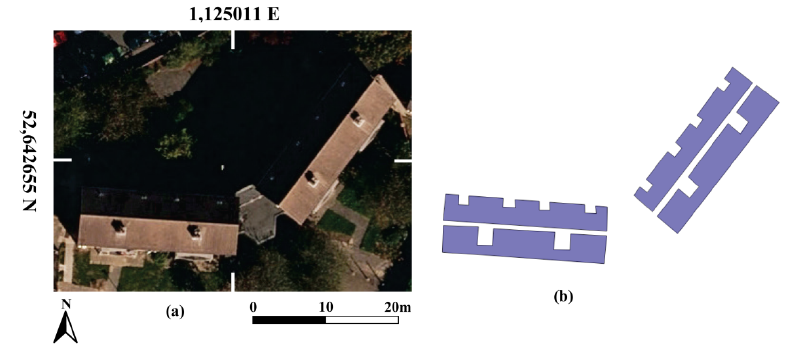
Figure 3. Reference roof planes of the Leicester test site created by manual measurement of aerial images. ( a ) Aerial image; ( b ) Reference planes. Disturbing objects have been excluded. Copyright © Bluesky International Ltd. (Leicestershire, UK).